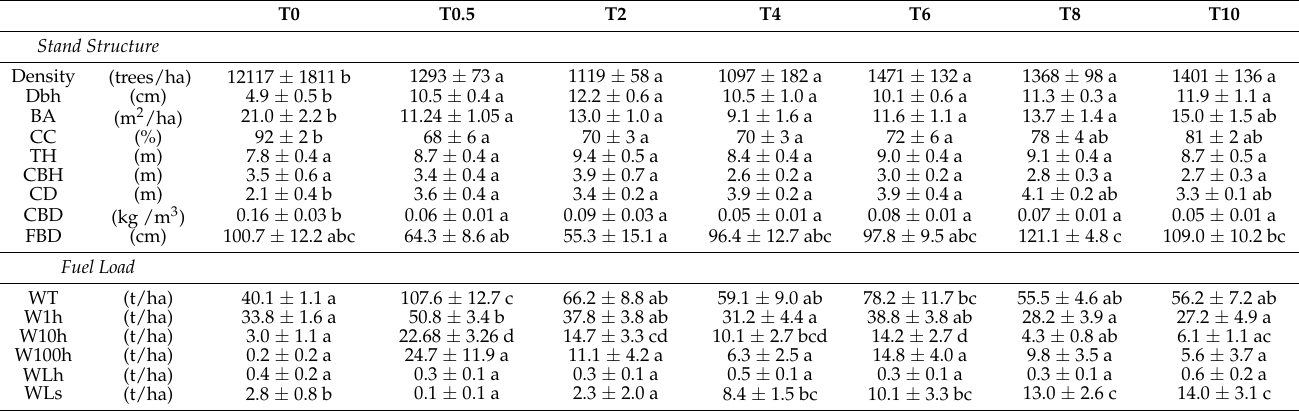
Table 1. Fuel characteristics of the stands depending on the time since treatment (mean ± std.dev) The forest structure variables are as follows: number of trees per hectare; mean diameter at breast height (Dbh); basal area (BA); horizontal projection of the canopy coverage (CC); mean tree height (TH); crown base height (CBH); diameter of the tree canopies (CD); canopy bulk density (CBD); and depth of the surface fuels (FBD). The variables related to the fuel load are as follows: the loads of the dead fuels according to their size (Total plus 1, 10, 100, 1000-h timelag); and the loads of life herbaceous fuels (WLh) and woody fuels